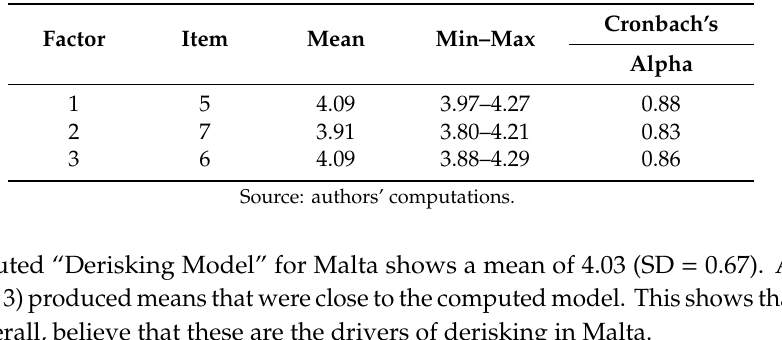
Table 3. Cronbach’s alpha values ( n = 317).